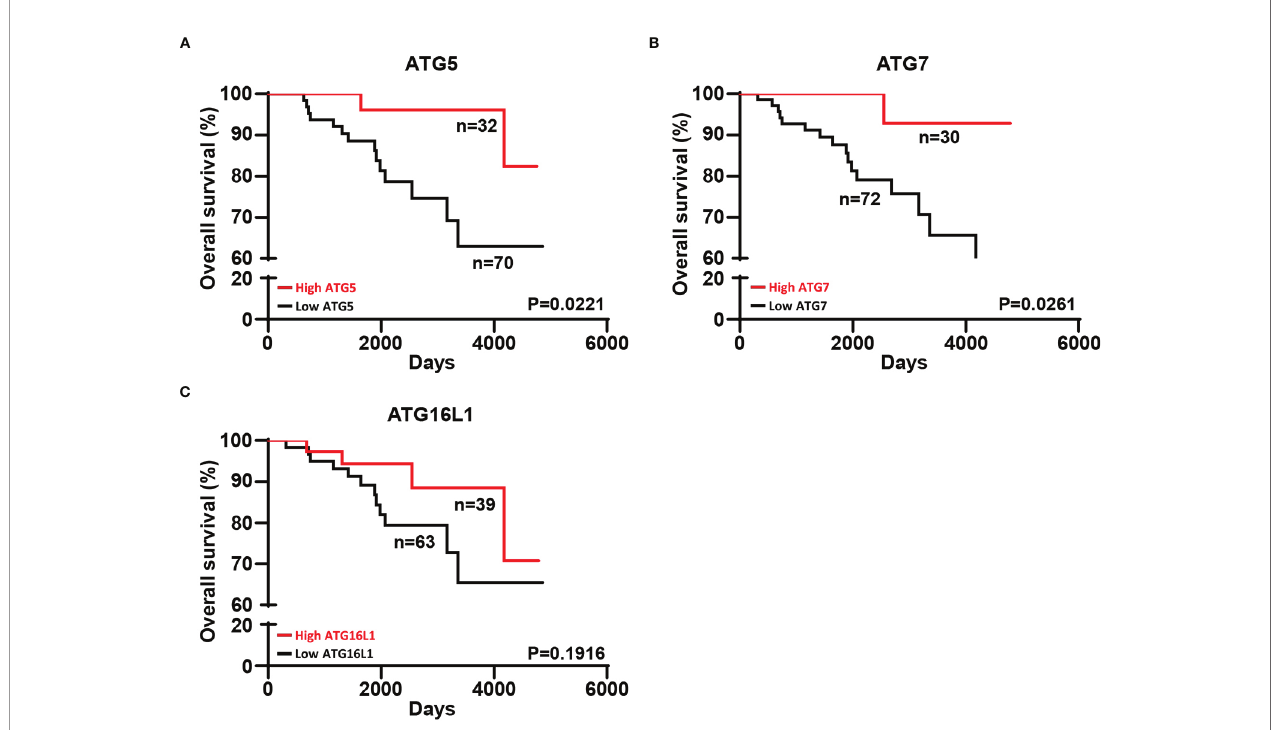
FIGURE 3 | Melanoma patients with high expression of ATG5 and ATG7 in their tumors exhibited a better overall survival. (A – C) The same follow-up patients were divided into two groups ( “ high ” and “ low ” ) on the basis of the mean expression of ATG5, ATG7, and ATG16L1 in their tumors. Kaplan – Meier curves for overall survival are shown. Statistical analysis was performed using a log-rank test. The hazard ratios (HR) with their corresponding con fi dence intervals (95%CI) were estimated for each group. Strata \high ATG5 ” [HR=0.2136;95%CI (0.0786 to 0.5806)], strata \high ATG7 ” [HR=0.1423;95%CI (0.0507 to 0.3995)], strata \high ATG16L1 ” [HR=0.4801;95%CI (0.1773 to